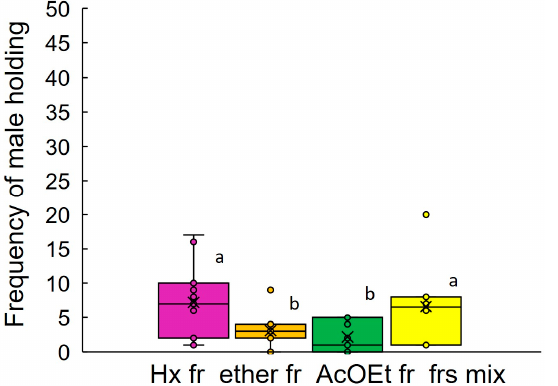
Figure 4. Box-plots of frequencies of A. glabripennis males holding onto glass models that were coated with fractions of conspecific female extracts (0.2 fe) (Bioassay 2). Hx: Hexane fr., ether: diethyl ether fr., AcOEt: ethyl acetate fr., frs. mix: blend of three fractions. 0.2 fe. N = 10–11. Box-plots: middle line, mean; boxes, 75 and 25% quartiles; x, average; whiskers, maximum and minimum values; o, outliers. p < 2.2 × 10 16 , GLM, Poisson (log). Frequencies were analyzed using Tukey’s multiple comparison test with Bonferroni’s correction at p < 0.05. Different letters indicate significant differences.